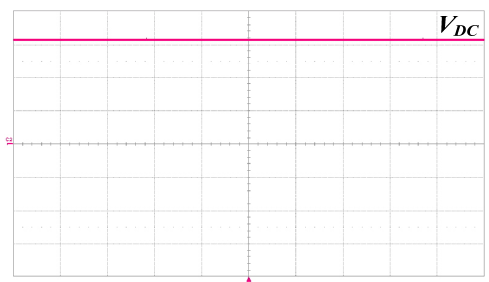
Figure 9. Measured DC (direct current) ‐ bus voltage V DC occurred on DC ‐ linked capacitors ( C DC1 and C DC2 ) (100 V/div); time scale: 5 μ s/div.